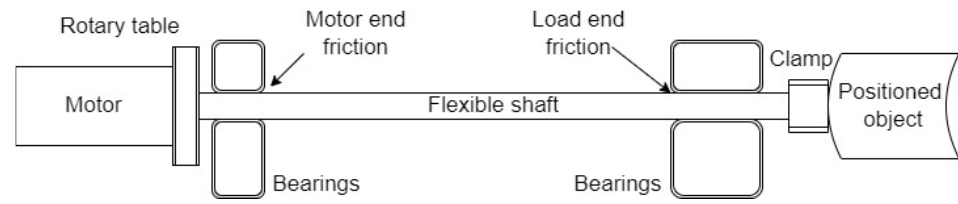
Figure 4. Schematic diagram of a drive with an elastic coupling.